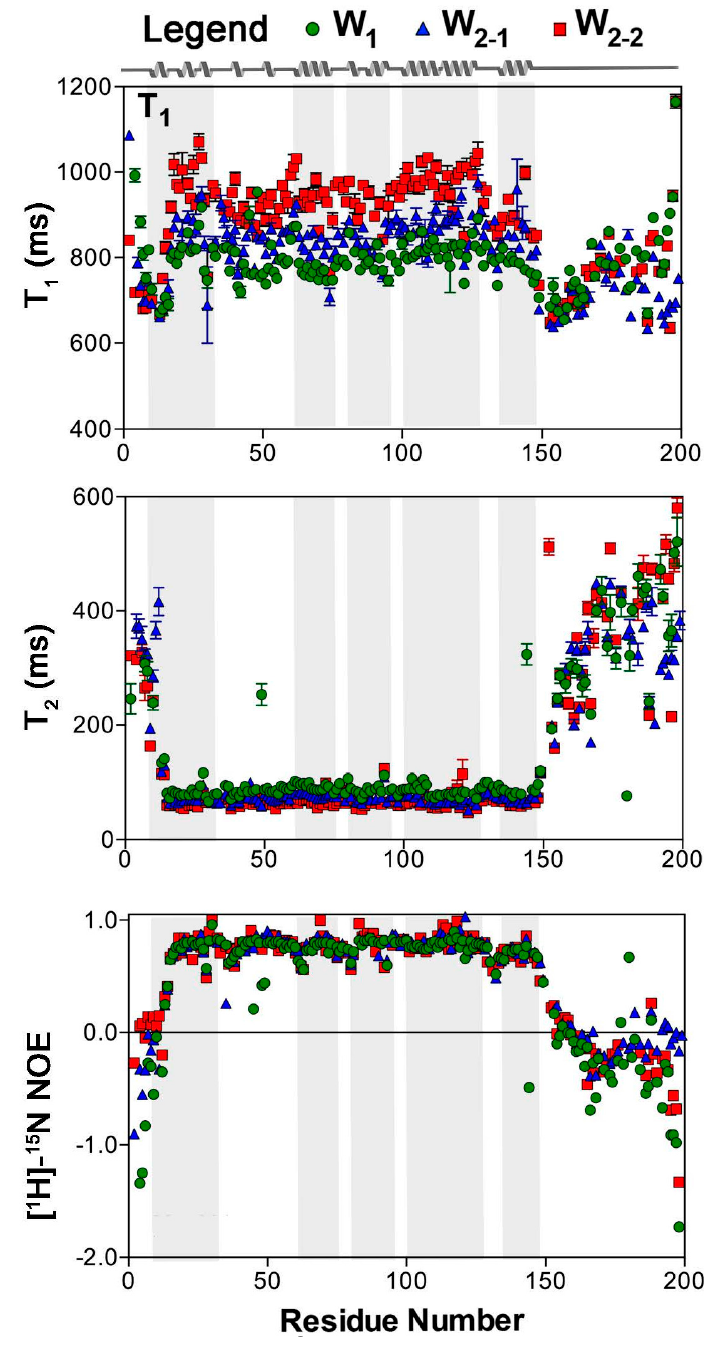
Figure 1. 15 N spin relaxation parameters as a function of residue at 16.4 T for W 1 , W 2-1 , and W 2-2 . Analysis and error propagation were carried out using Mathematica notebooks from Leo Spyracopoulos [51]. The secondary structuring of the W unit is depicted on the basis of PDB entry 2MU3 [19], with grey shading for each helical segment.